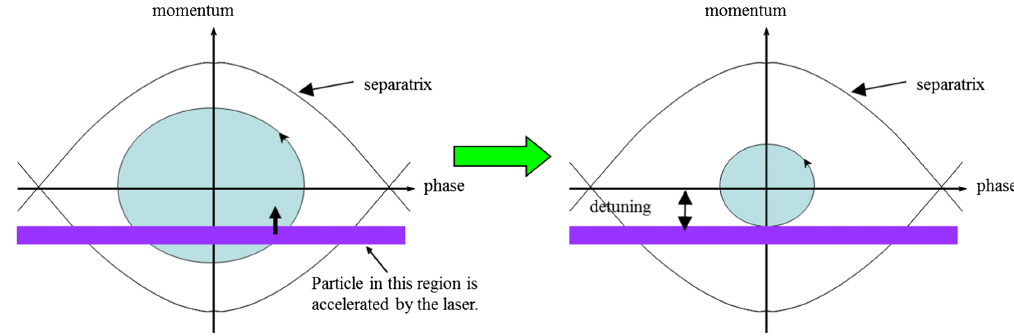
FIG. 1. Schematic diagram of Doppler laser cooling of a bunched beam. Each ion circulates around the origin in the longitudinal phase space at the frequency determined by the synchrotron tune. Ions with large synchrotron-oscillation amplitudes periodically come into the laser-cooling band and absorb and emit many photons. Since the laser is copropagating with the beam in S-LSR, the ions are accelerated after photon absorption, which effectively reduces the synchrotron amplitudes. As a result, the beam is compressed in the phase plane as illustrated in the right